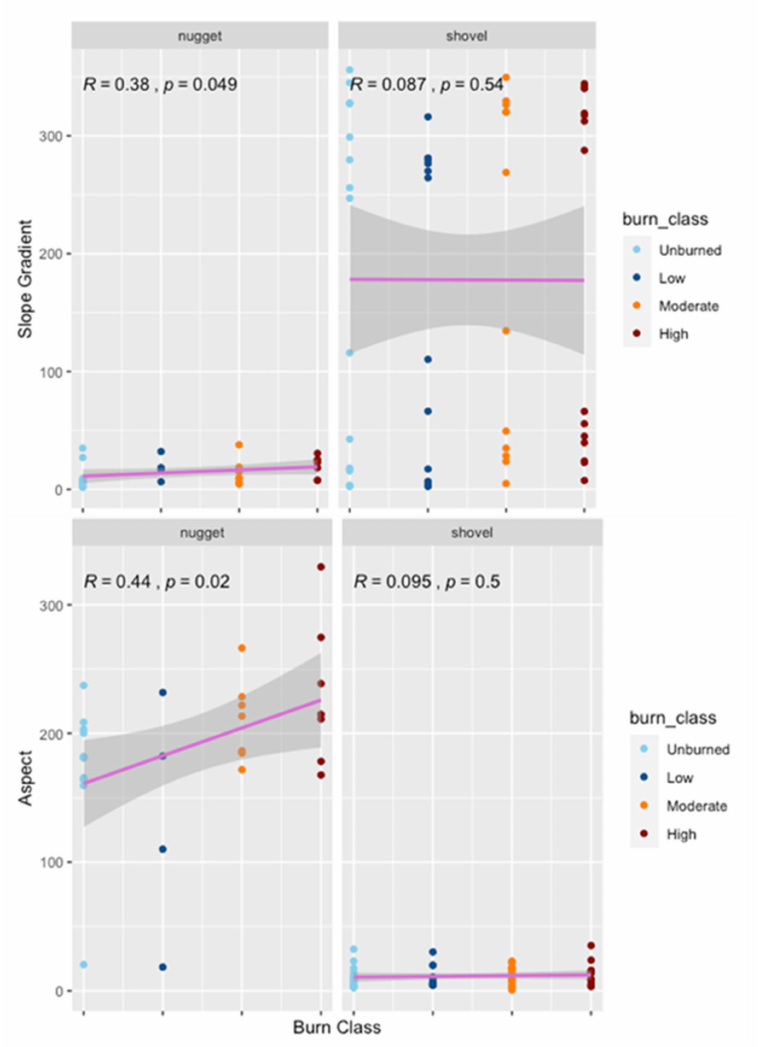
Figure 8. Graphs showing the relationship between slope gradient and burn severity classes (top plots) by site (left: Nugget Creek; right: Shovel Creek) and aspect by burn severity classes (bottom plots). Top left in each panel shows the Spearman correlation and significance of the relationship. Pink lines show the